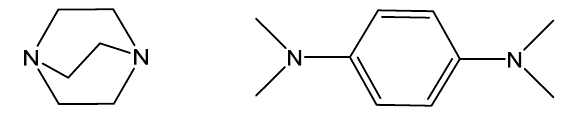
Scheme 1. Structures of DABCO ( left ) and TMPD ( right ).